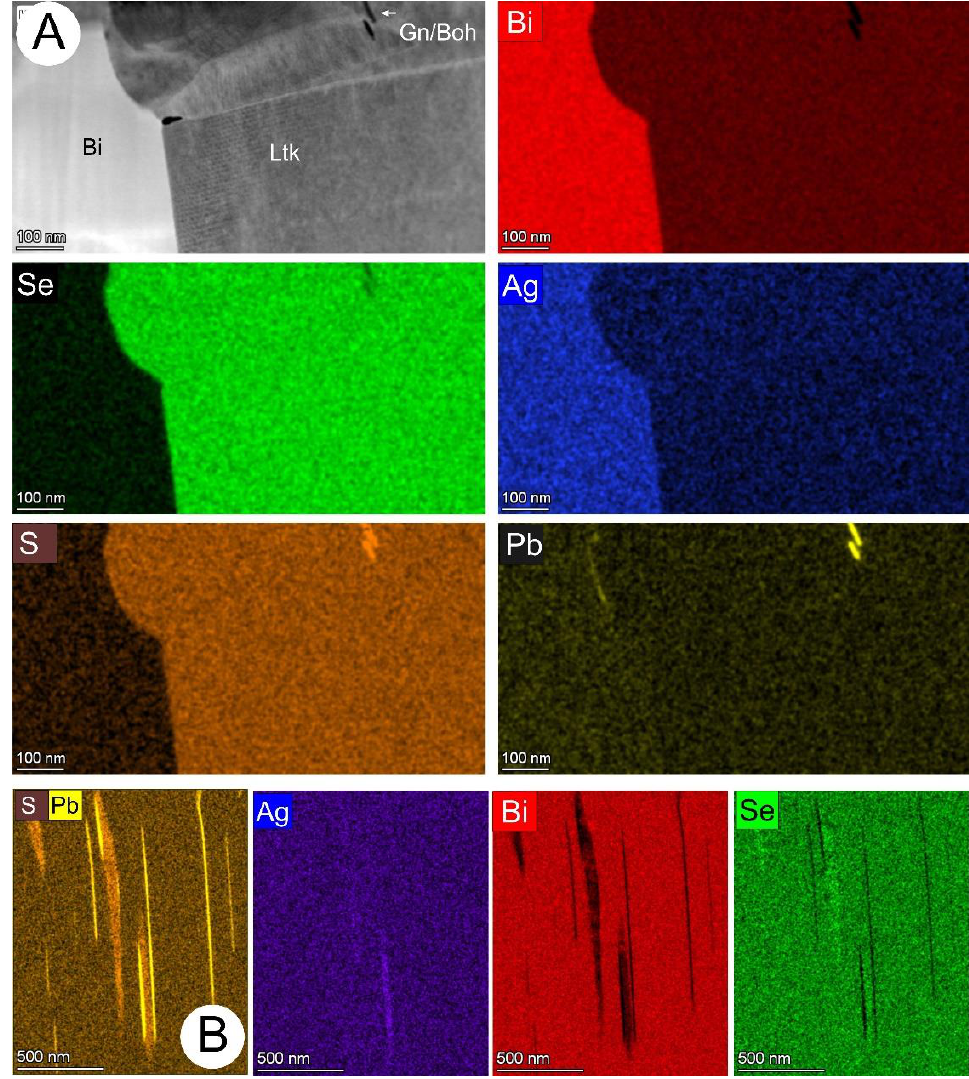
Figure 5. ( A ) STEM EDS element maps showing laitakarite (Ltk) adjacent to native bismuth, and ( B ) sets of acicular inclusions with galena (Gn) and bohdanowiczite (Boh), also arrowed in ( A ).